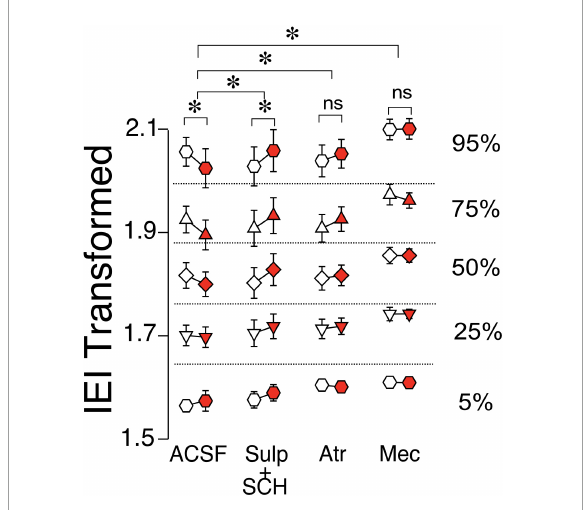
FIGURE6 Effects of ChI stimulation in DID D1-MSNs in the presence of antagonists. IEI in DID D1-MSNs EPSCs shown as percentiles of cumulative distribution. Data for the control group (ACSF) is reproduced from Figure 5F . Each group of Pre (white circles) and Post (red circles) column is recorded either without (ACSF) or with the bath presence of antagonists: Sul + SCH (5 uM SCH-23390, D1 receptor antagonist + 1 uM sulpiride, D2 receptor antagonist), Atr (1 uM atropine, mAChR antagonist), Mec (5 uM mecamylamine, nAChR antagonist). * p < 0.05, ns, no significant